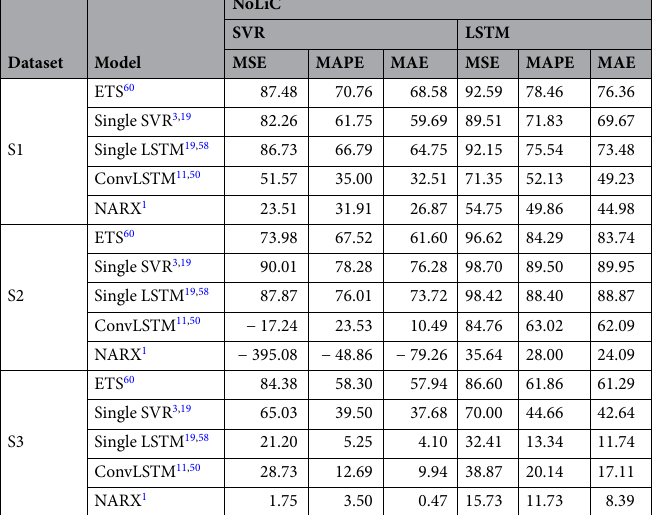
Table 6. Percentage difference between the NoLic and literature models for MSE, MAPE, and MAE.